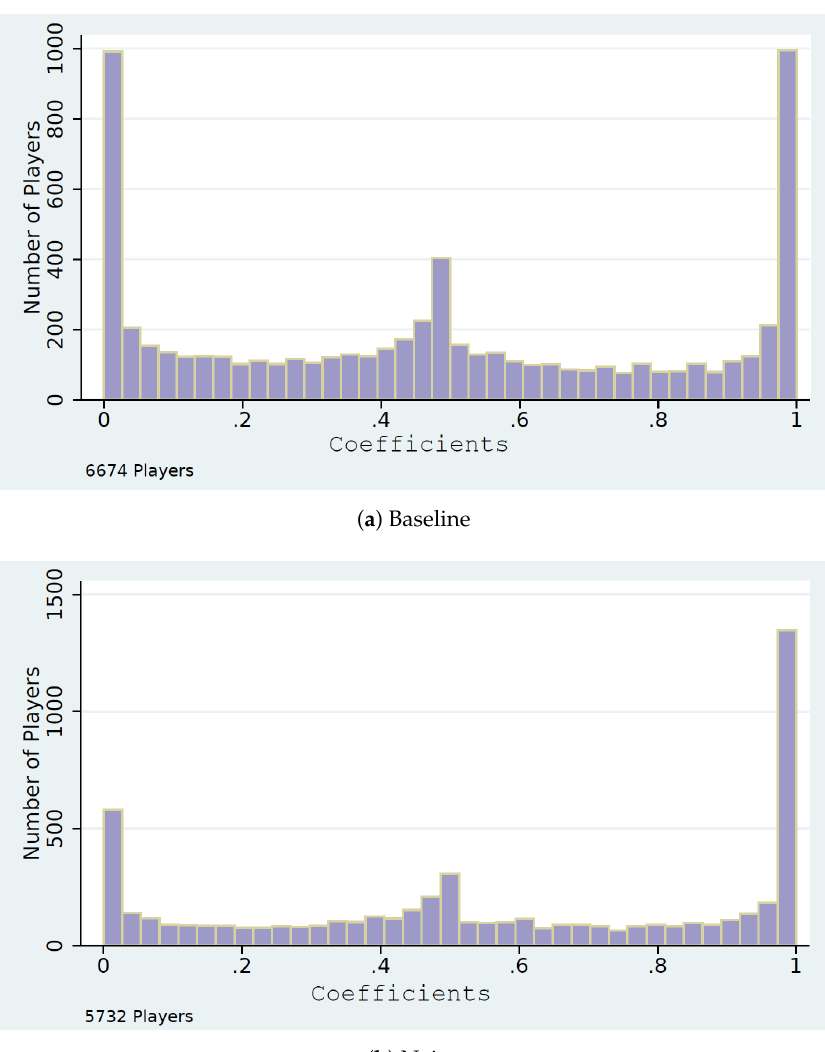
Figure 8. Probability of the level- k 1 model. Note: For each player we calculate the probability that the data were generated by the quantal response model as opposed to the level- k 1 model, assuming a flat prior, as in Equation